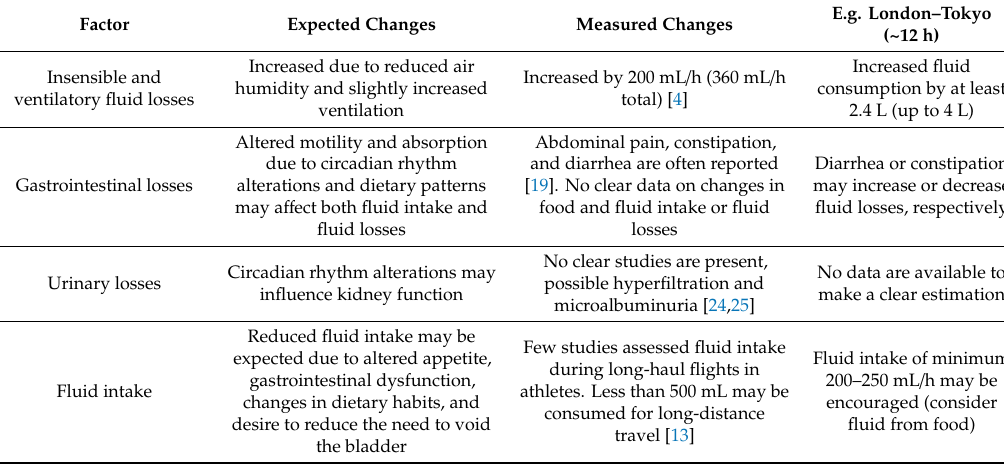
Table 1. Factors influencing fluid balance during long-haul